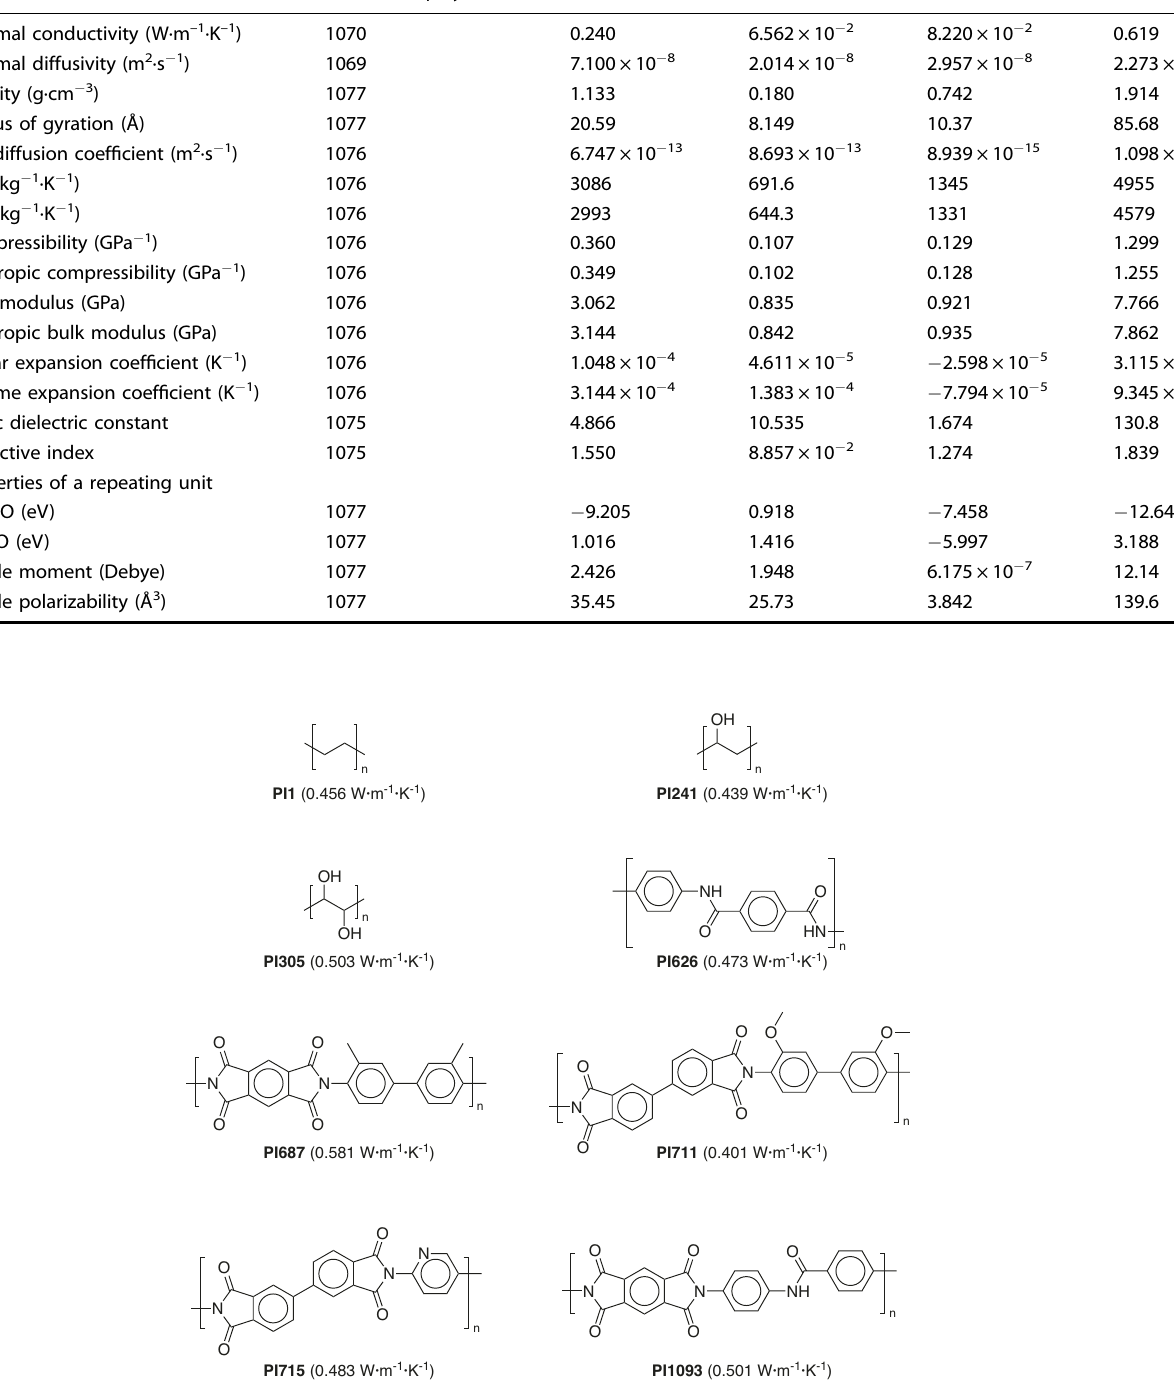
Fig. 5 Repeating units of identi fi ed polymers exhibiting a high thermal conductivity in amorphous states. The compound identi fi er corresponds to the polymer ID in the calculated